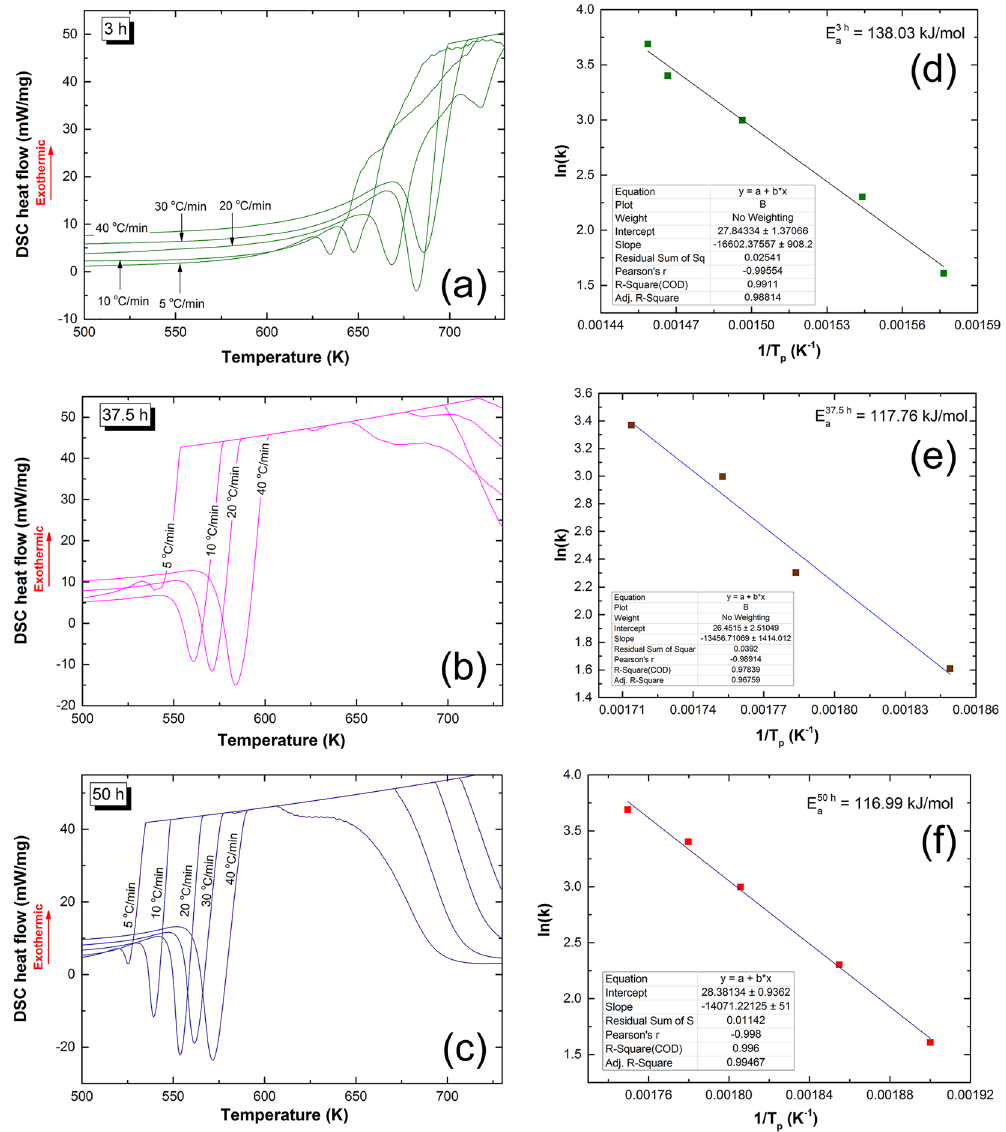
Figure 4. Dependence of activation energy on the RBM time for nanocomposite MgH 2 /5 wt.% TiMn 2 powders. DSC curves of the nanocomposite powders obtained after RBM time of ( a ) 3 h, ( b ) 37.5, and ( c ) 50 h. The apparent activation energy (E a ) was calculated from the slope of line shown in the Arrhenius plots, displayed in ( d ), ( e , f ) for the samples milled for 3 h, 37.5 h, and 50 h,